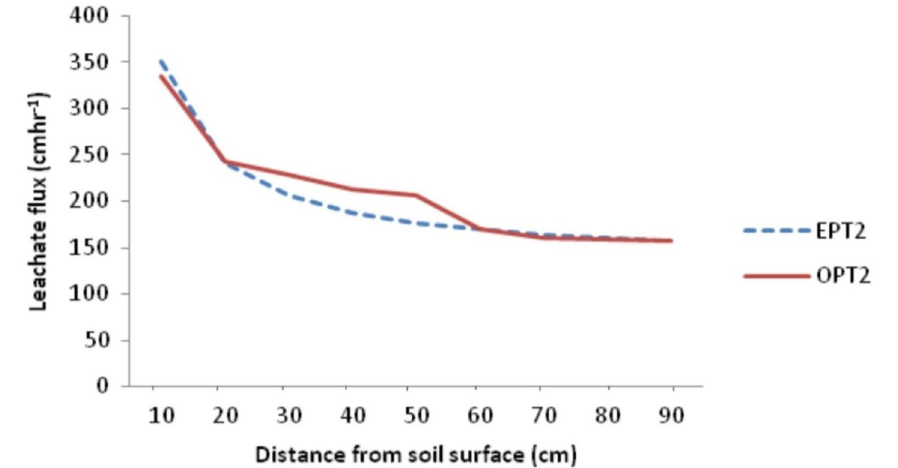
Figure 7. Pattern of observed and estimated leachate flux at PT02 in the dumpsite soil.